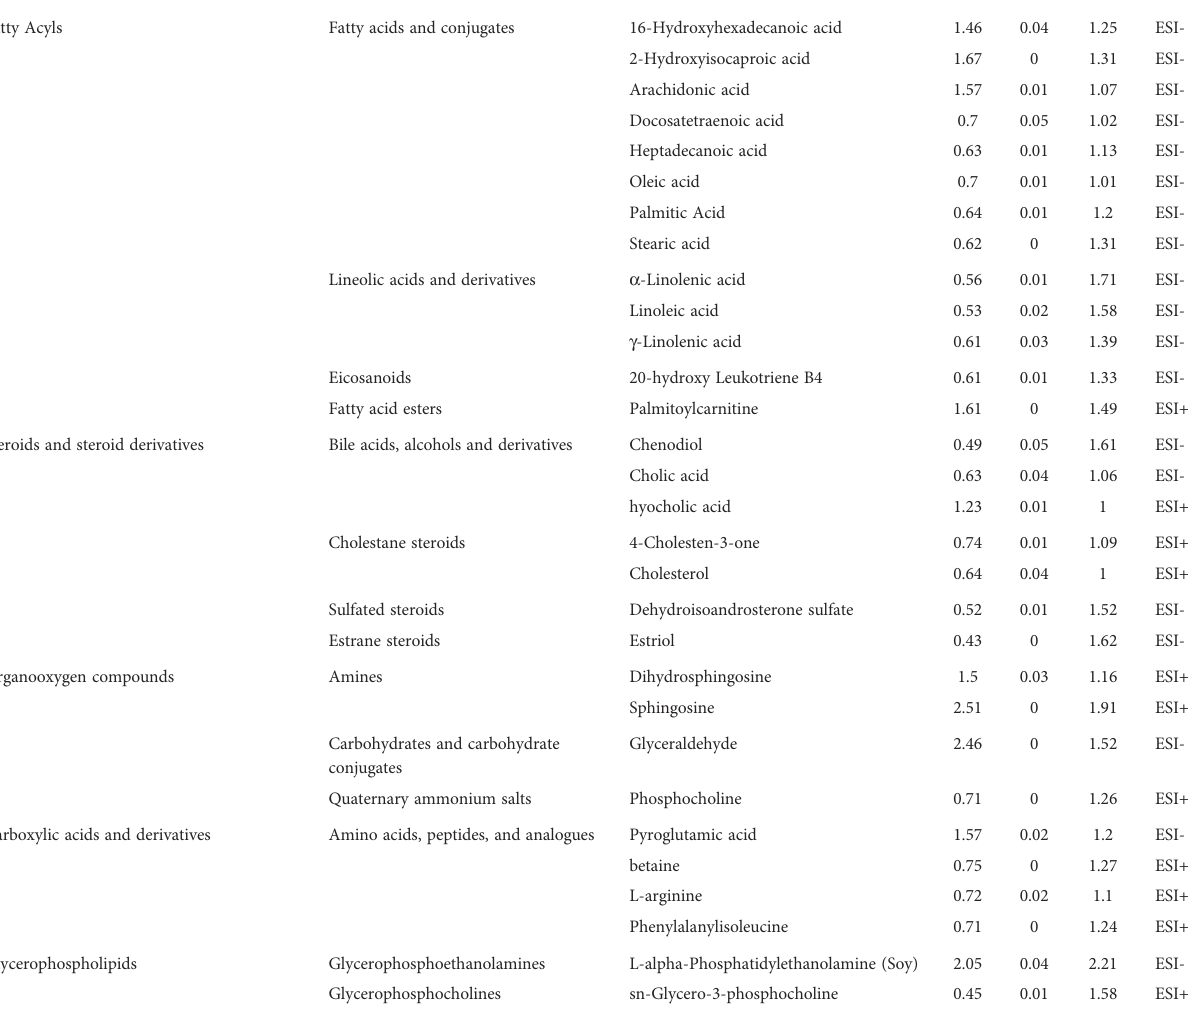
TABLE 2 Signi fi cantly altered metabolites in keloid vs. normal controls in the analysis of ESI+ mode and ESI- mode. Fatty Acyls Fatty acids and